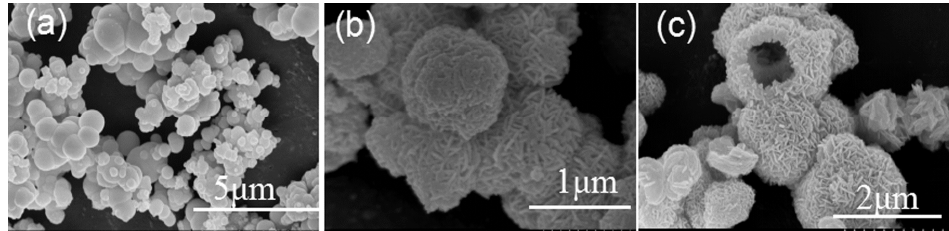
Figure 6. Scanning electron microscopy (SEM) images of samples obtained at 160 °C for ( a ) 1 h, ( b ) 2 h, and ( c ) 4 h, respectively.